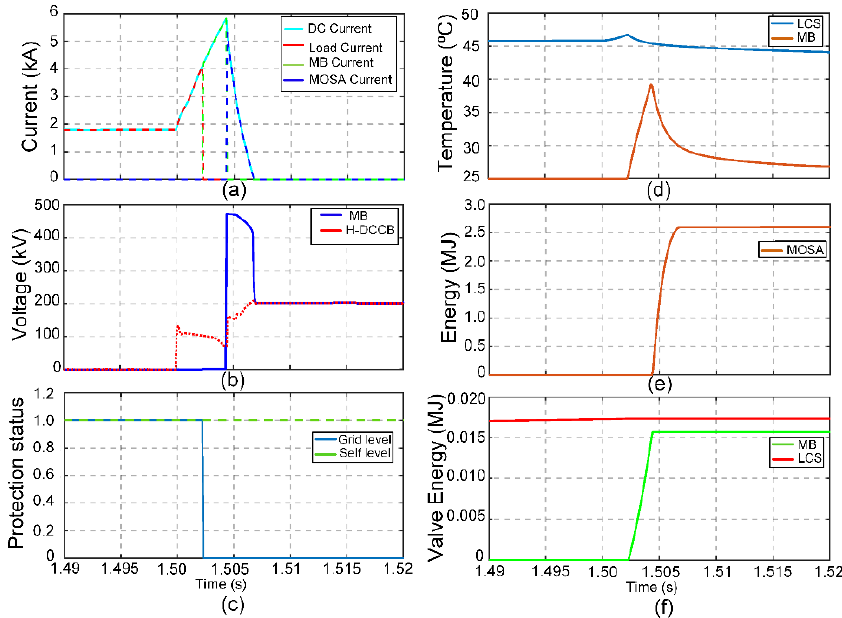
Figure 8. High impedance fault interruption under grid-level protection, ( a ) current ( b ) voltage, ( c ) protection status, ( d ) valve temperature, ( e ) MOSA energy, ( f ) valve energy.